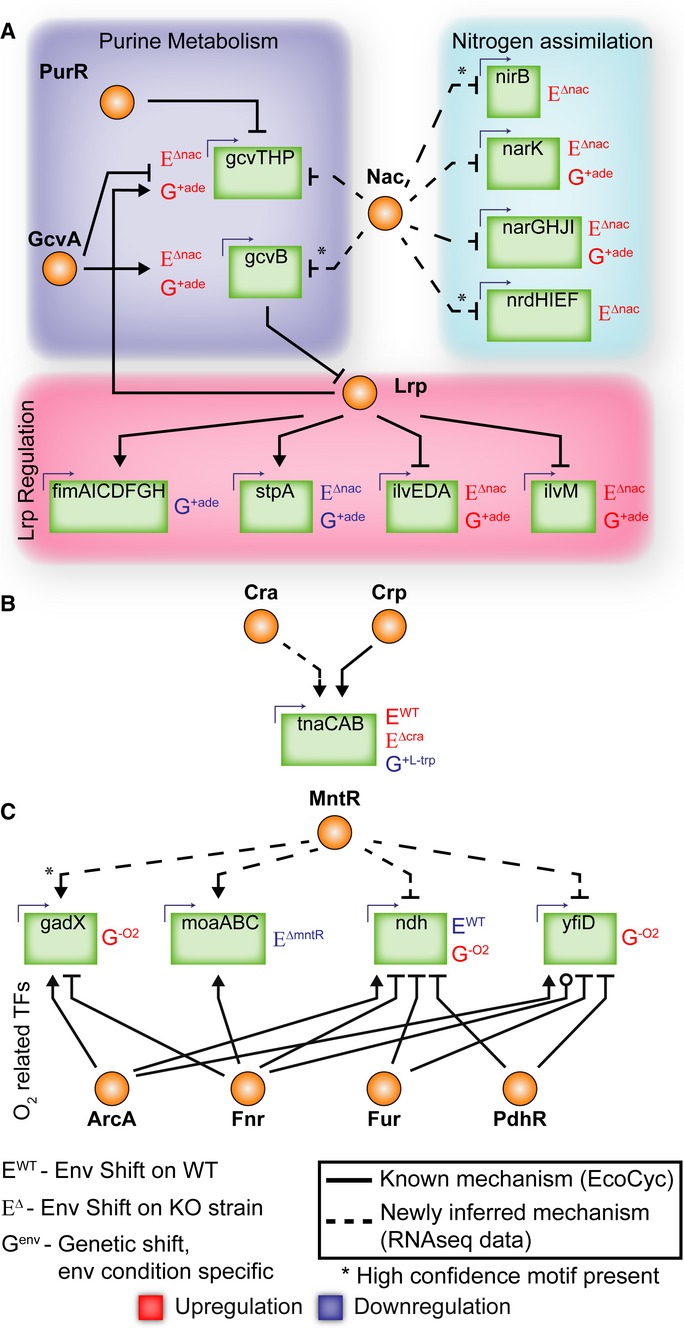
MinSpan TRN predictions suggest informative dual perturbation experiments that led to
discovery of novel Escherichia coli transcriptional regulationNac plays a role in purine metabolism and a larger role in nitrogen metabolism than previously
known. Nac also regulates Lrp through gcvB.Cra regulates tnaCAB, which is also subject to Crp regulation.MntR plays a regulatory role for four genes that are heavily regulated by ArcA/Fnr/Fur/PdhR and
are utilized during anaerobic conditions.